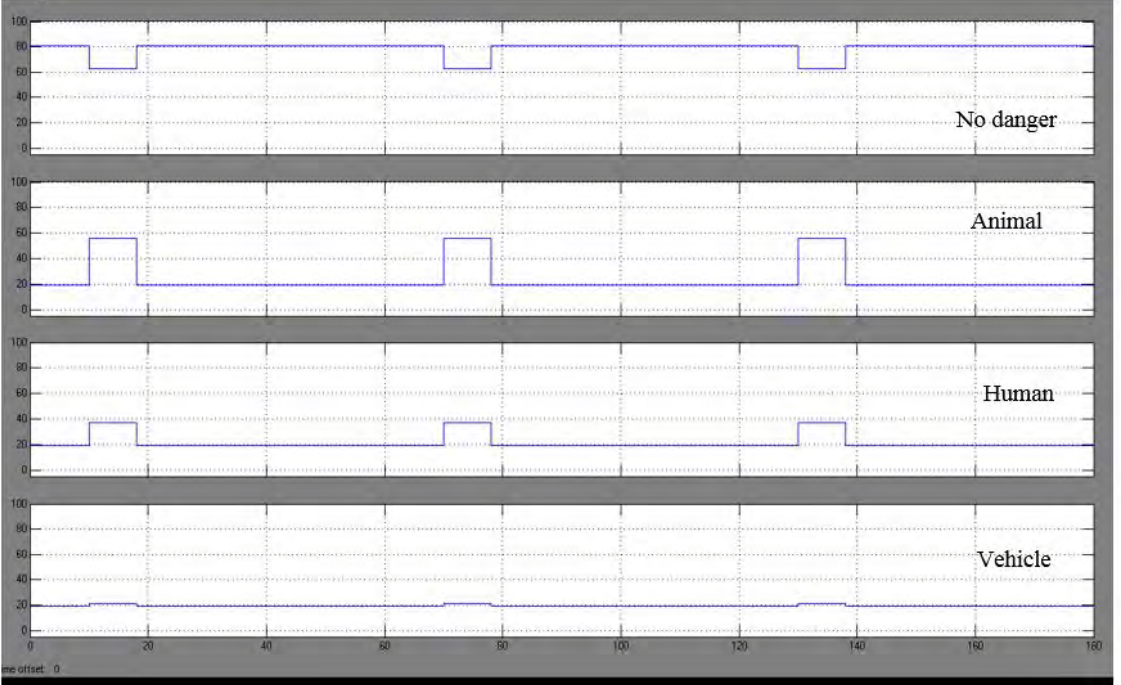
Figure 13. The corresponding outputs of the three inputs (2, 0, and